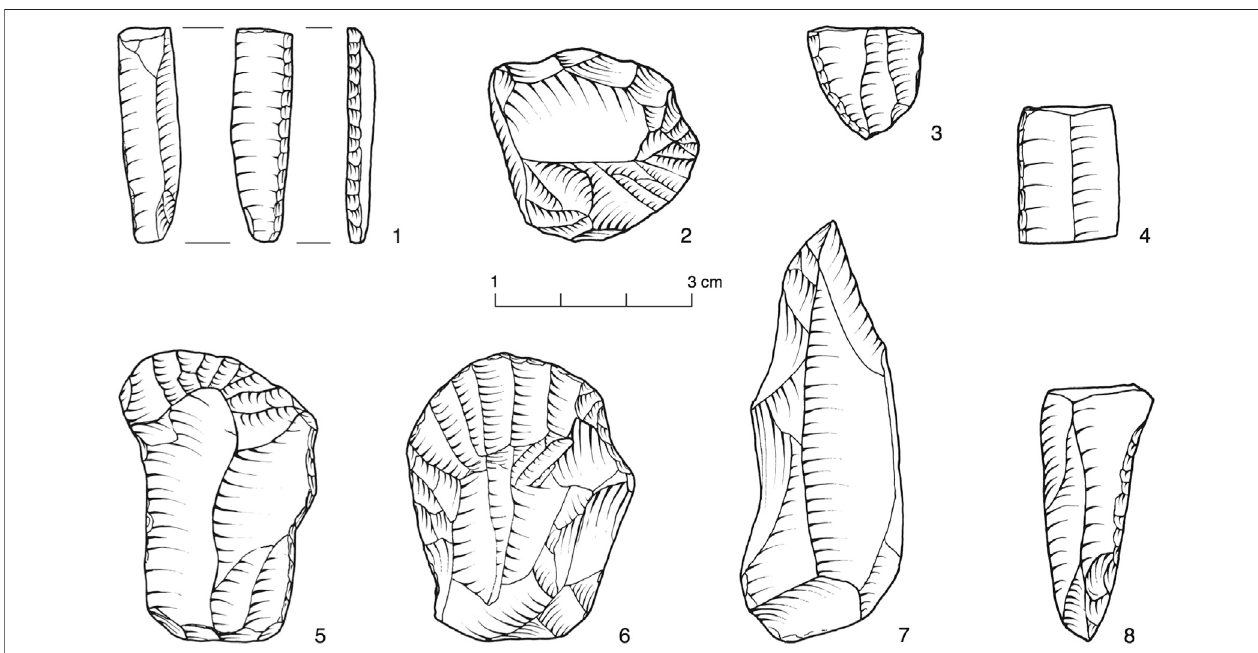
FIGURE 3 | Selected lithic artifacts from the Crvenka-At 2015 excavations (from Chu et al., 2016a).